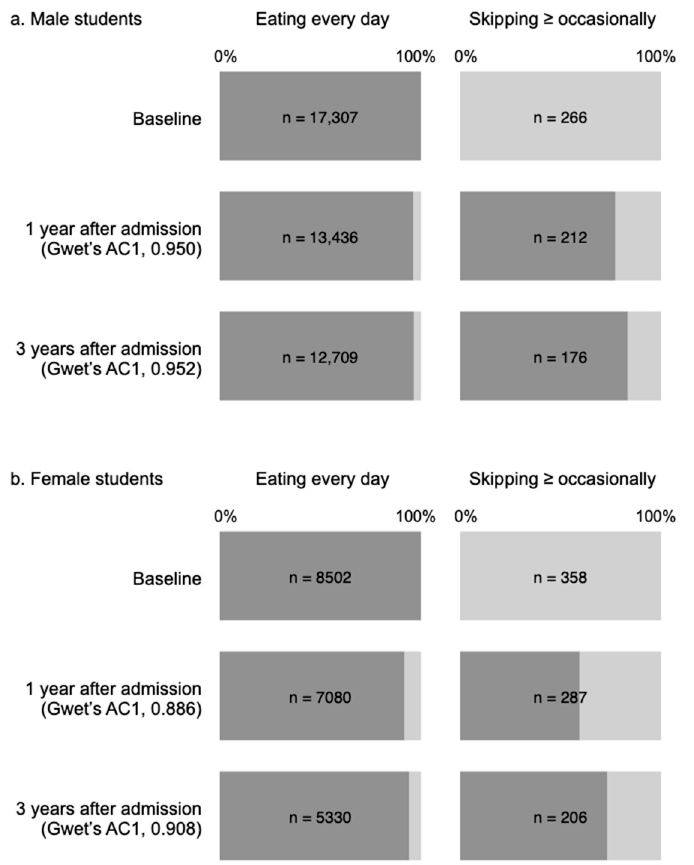
Figure 4. Baseline dinner frequency and dinner frequency 1 and 3 years after admission in male ( a ) and ( b ) female students. Dark and pale gray bars indicate the proportion of eating dinner every day and skipping dinner ≥ occasionally, respectively. In both male and female students, baseline dinner frequency reflected dinner frequency 1 and 3 years after admission almost perfectly (Gwet’s AC1 coefficient